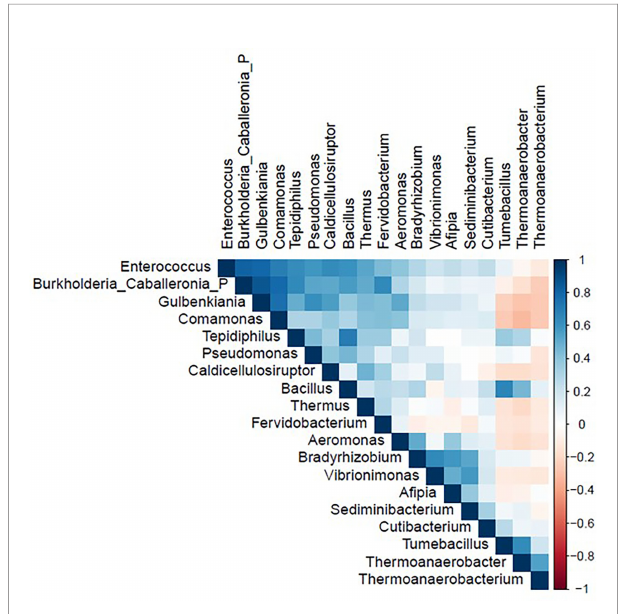
FIGURE 2 | Correlation matrix of nineteen genera used in the factor analysis in the study population (N = 54). Figure generated by R software (version 4.1.2